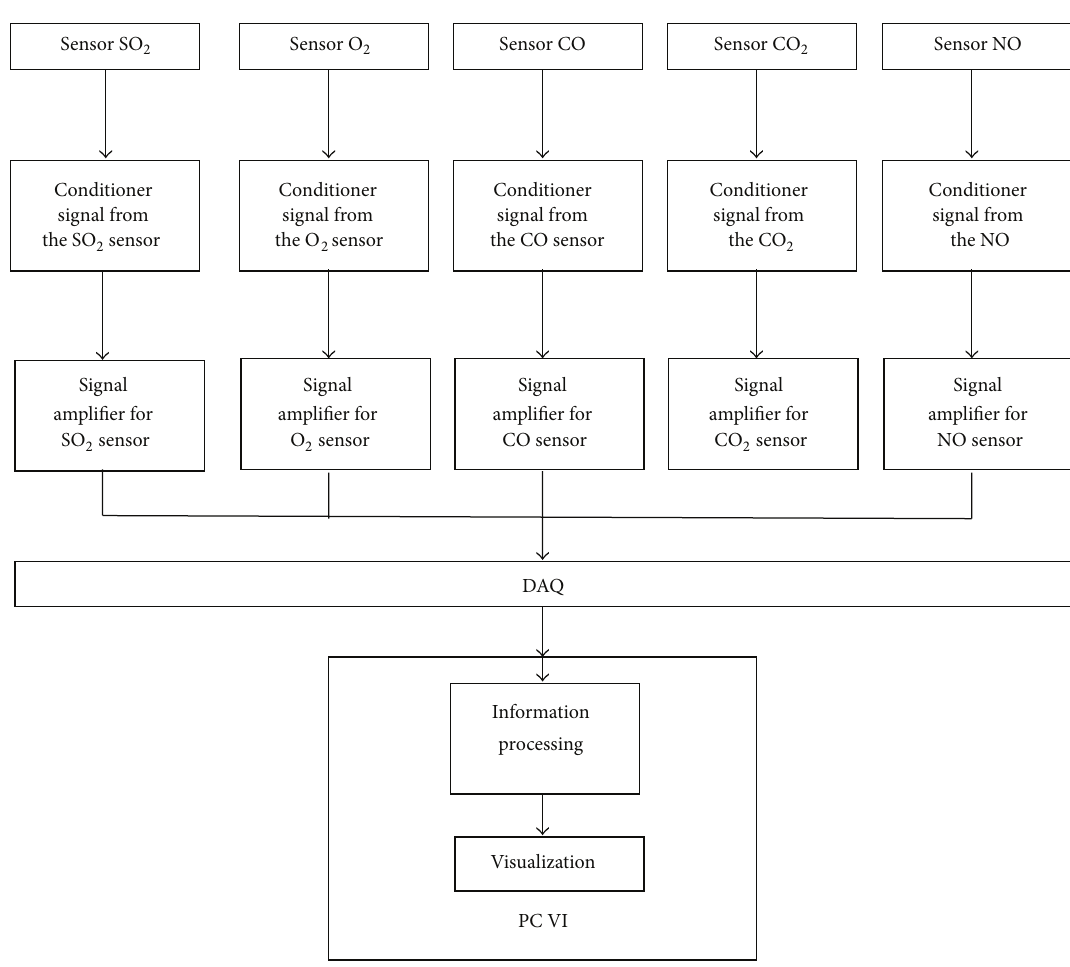
Figure 1: Operating block diagram of VIEM.